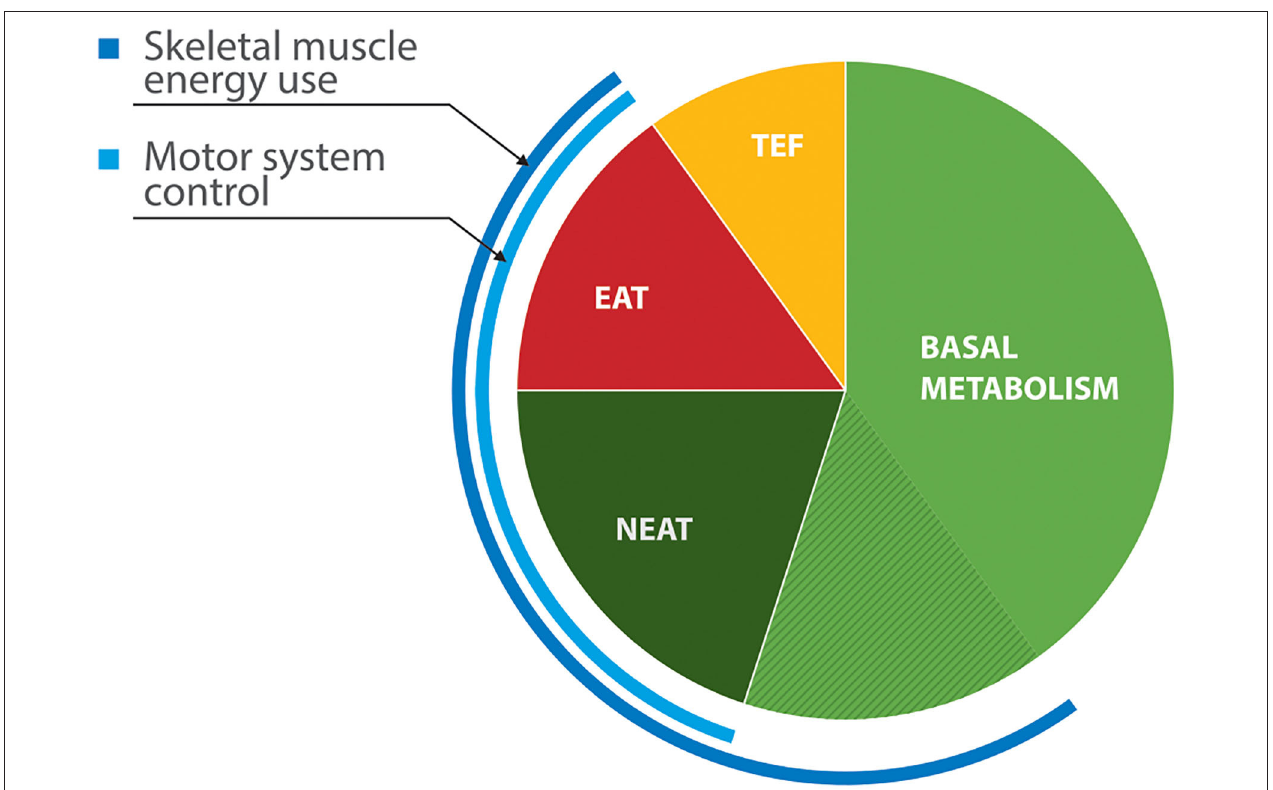
FIGURE 1 | Components of energy expenditure in non-obese healthy adults (39, 40). EAT, exercise activity thermogenesis; NEAT, non-exercise activity thermogenesis (low-level physical activities of daily living, including some locomotion, upper limb movement, postural tone and maintenance); TEF—thermal effects of food (digestion and secondary metabolism). Skeletal muscle contributes roughly 20% of basal metabolic